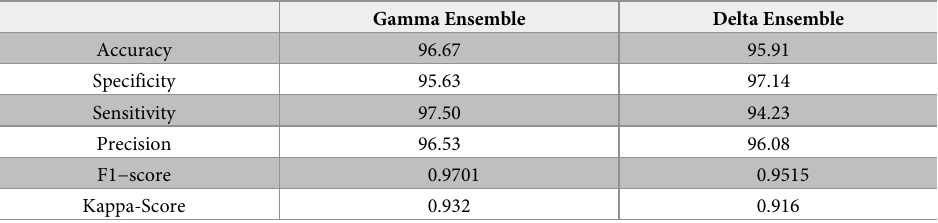
Table 3. Performance of Gamma and Delta